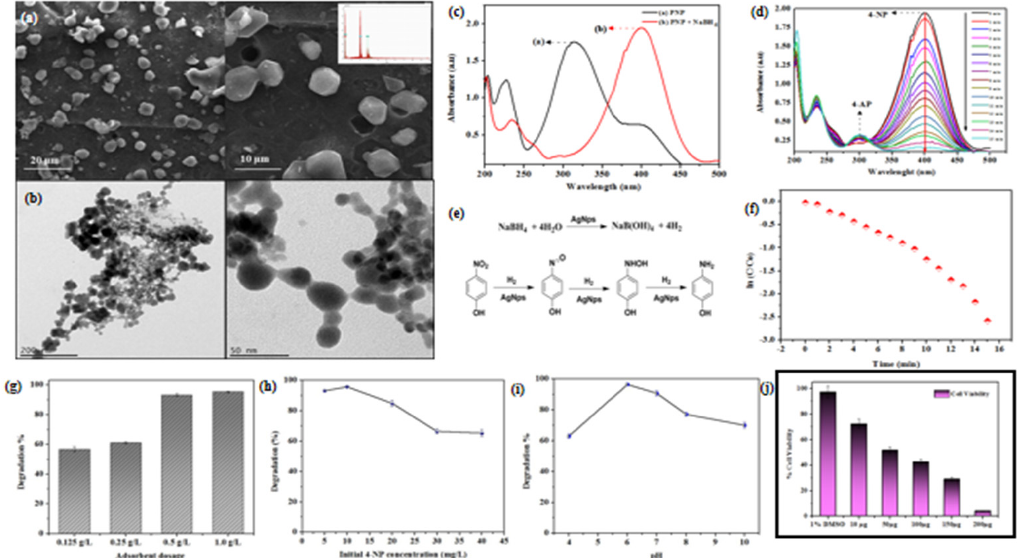
Figure 7. ( a ) SEM analysis. The EDX insert shows that the formed nanoparticles are silver. ( b ) TEM image showing the synthesized AgNPs using B. amyloliquefaciens. ( c ) Absorption spectra of 4- nitrophenol in aqueous medium and 4-nitrophenol+NaBH 4 in aqueous solution. ( d ) Absorption spectra for reduction of 4-nitrophenol by NaBH 4 in aqueous medium in presence of biosynthesized AgNPs as catalyst. ( e ) Kinetic modeling of the 4-nitrophenol reduction in the presence of biosynthesized AgNPs. ( f ) Mechanism of reduction of 4-nitrophenol (4-NP) to 4-aminophenol (4- AP) using biosynthesized AgNPs catalyst. ( g ) Effect of adsorbent dosage on the degradation of 4- NP. ( h ) Effect of initial dye concentration on the degradation of 4-NP (experimental conditions: H 2 O 2 : 40 mM; AgNPs: 0.5 g/L; initial pH: 5.5). ( i ) Effect of initial pH on the degradation of 4-NP (experimental conditions: 4-NP: 10 mg/L; AgNPs: 0.5 g/L; H 2 O 2 : 40 mM). ( j ) Effect of hydrogen peroxide (H 2 O 2 ) on the degradation of 4-NP (experimental conditions: 4-NP: 10 mg/L; AgNPs: 0.5 g/L; initial pH: 6. Effect of biosynthesized AgNPs on A549 lung carcinoma epithelial cells at 50–200 μ g for 24 h [11]. Silver nanoparticles (AgNPs) with a very high antibacterial potential can be synthesized extracellularly by employing the bacterium Bacillus cereus . Nanotechnologies have facilitated several sophisticated solutions for counteracting issues of water contamination and are likely to produce many strategies composed of enhancements in the future. Treatments based on nanotechnology offer highly effective, durable, efficient and eco-friendly approaches. These strategies are cost-effective, less time-consuming, and energy-efficient, with much lower waste generation than conventional bulk-materials- based technologies. However certain precautions are necessary for avoiding threats to human health or the environment [103]. 6. Cosmetics and Food Industry Applications of nanotechnology and nanomaterials are widely present in several cosmetic products such as moisturizers, hair care products, makeup accessories, and sunscreen. The main uses for nanotechnology in cosmetics are as follows. NPs are employed in cosmetics as UV filters. TiO 2 and ZnO are the key compounds used in these applications. Organic substitutes for these have also been established. Nanotechnology is also used for delivery. The cosmetic industry takes advantage of liposomes as vehicles for delivery. Novel structures comprising solid lipid NPs and nanostructured carriers composed of lipids have been reported to perform better than liposomes. NPs also enhance and facilitate penetration. Encapsulation or suspension of the key ingredients in nanospheres or nanoemulsions facilitates skin penetration. Regarding NPs in hair-related products, the employment of nanoemulsions for the encapsulation of desired substances facilitates their delivery into the deeper hair shafts. In sunscreen lotions, the employment